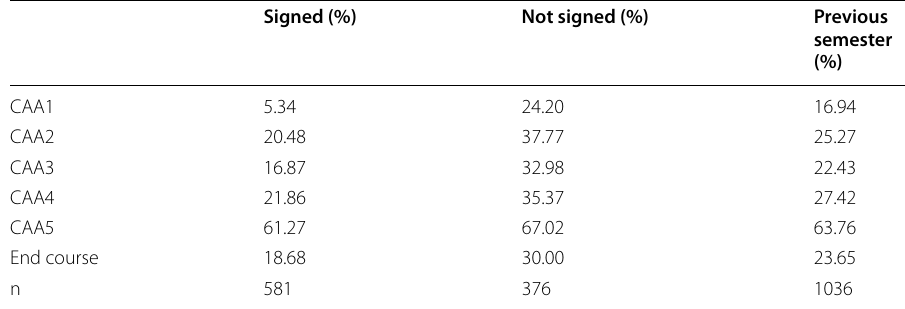
Table 6 Dropout by each group of participants Signed